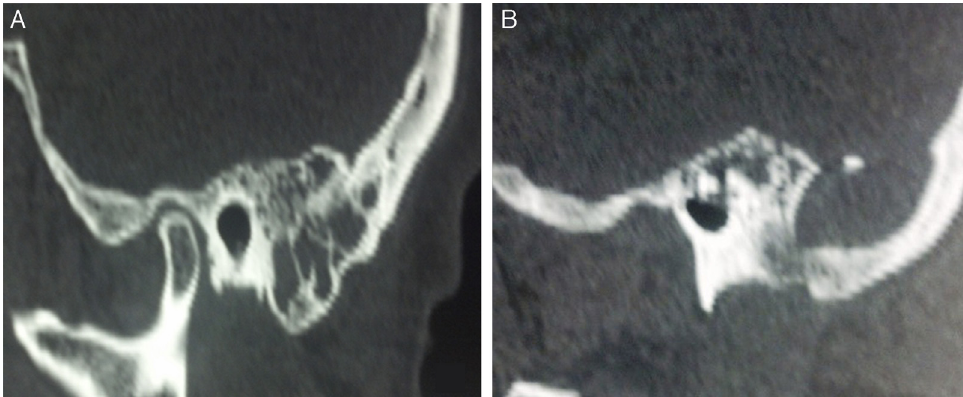
Figure 1 (A) Temporal bone CT scan: thickened mucosa within the mastoid air cells. (B) Presence of an expansive osteolytic temporal bone lesion; note the destruction of mastoid apex.